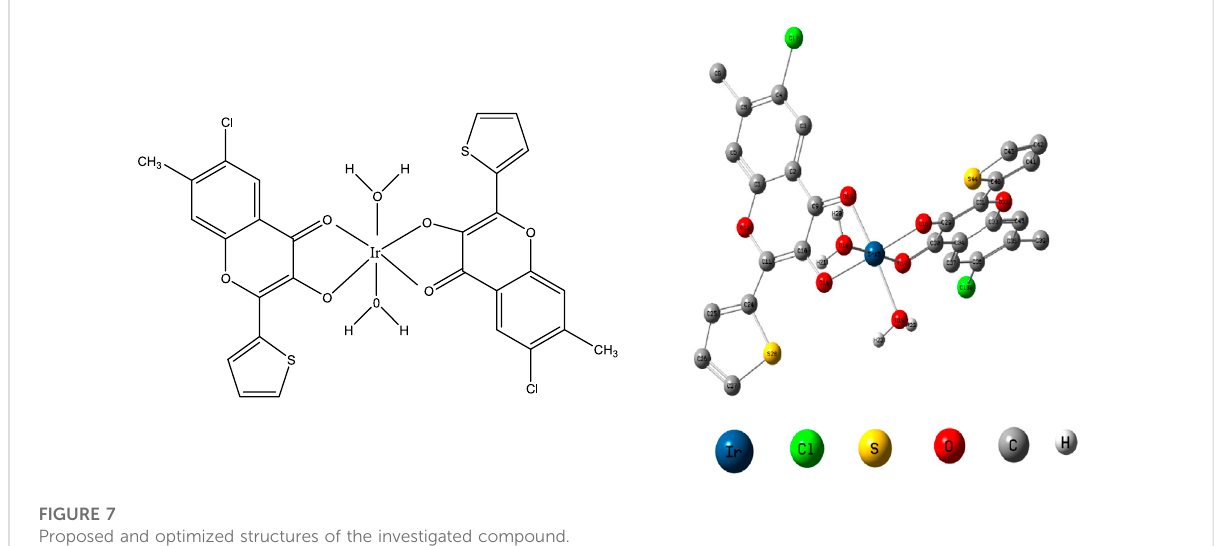
FIGURE 7 Proposed and optimized structures of the investigated compound.